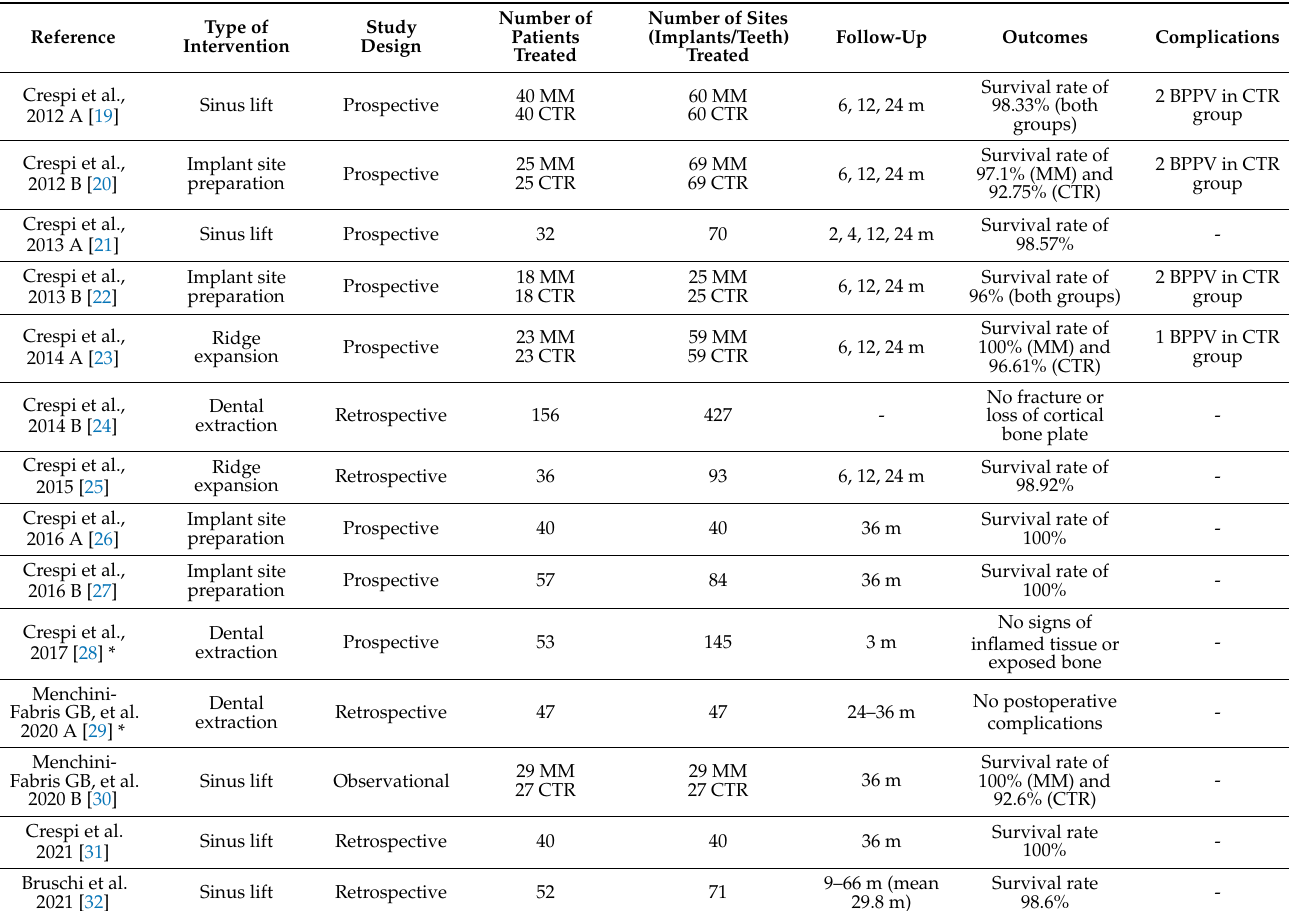
Table 1. Specific features and outcomes of the studies